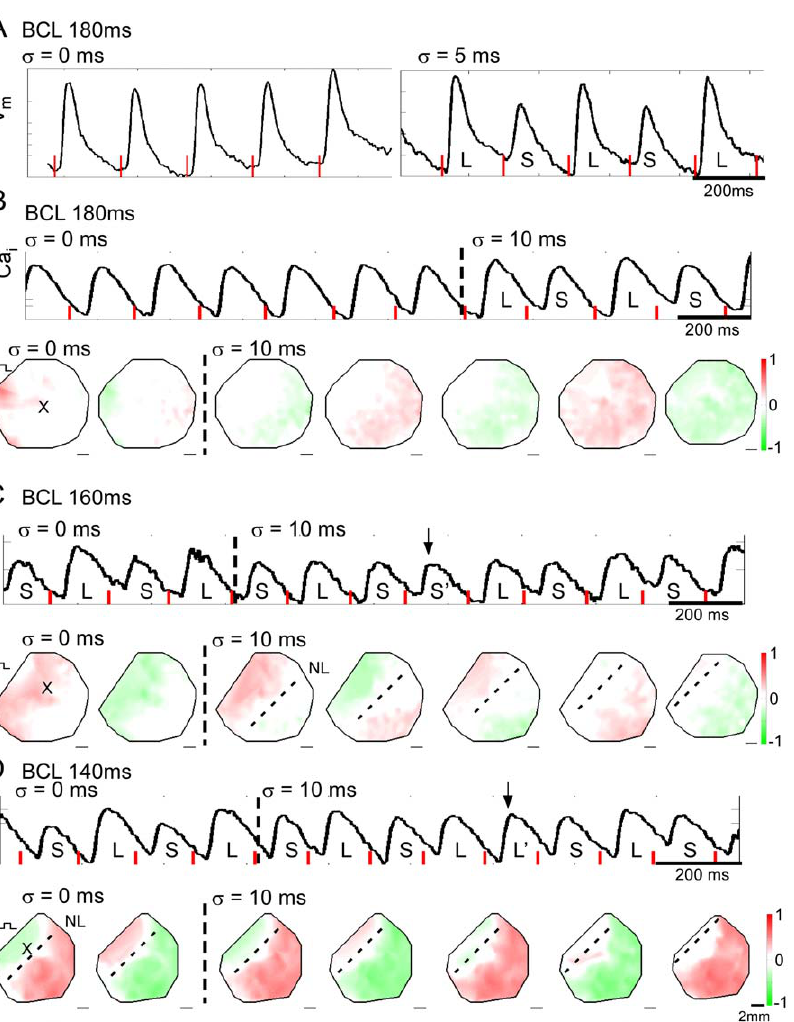
Figure 4. Cycle length oscillation in a cell monolayer. A. V m before and during CLO. L and S indicate long and short APDs, respectively. B , C , and D. Ca i traces and successive Ca i alternans maps before and during CLO. Trace is from site indicated by x on the map. L and S indicate large and small amplitude transients, respectively. Red lines indicate timing of stimuli, and pacing site and nodal lines (NL) are indicated by square pulse symbol and dashed lines on alternans maps, respectively. CLO for the case of no or small amplitude alternans at BCL =180 ms ( B ), spatially concordant alternans at BCL =160 ms ( C ), and spatially discordant alternans at BCL =140 ms ( D ) induced by constant pacing prior to CLO ( s =10 ms). Recordings in B , C , and D are from the same monolayer, and A is from a different monolayer. Phase reversals are indicated by the black arrows.